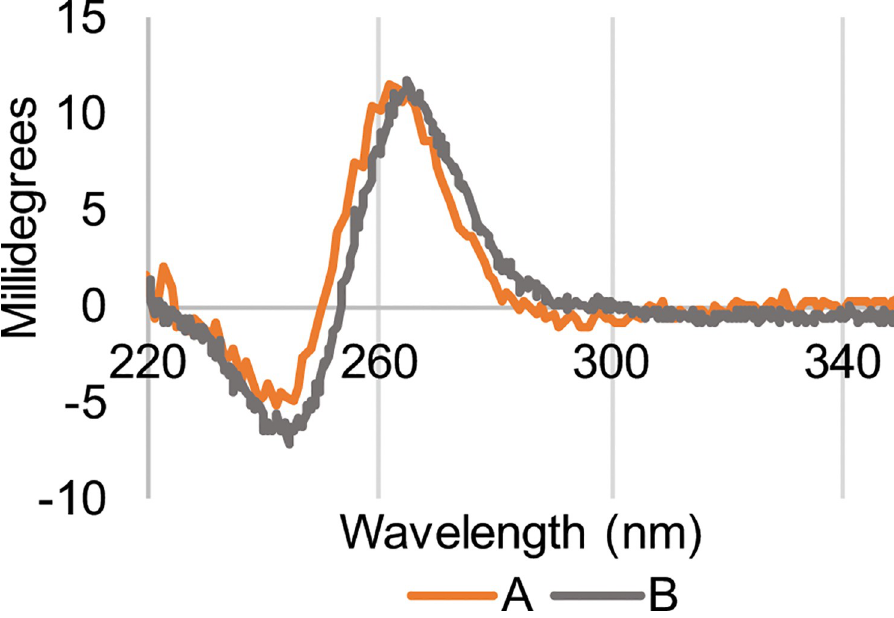
Fig 7. Circular dichroism spectroscopy. CD spectra of the Pu22 oligonucleotide under crystallization conditions (A) or conditions previously reported to form the parallel c-MYC promoter quadruplex (B).